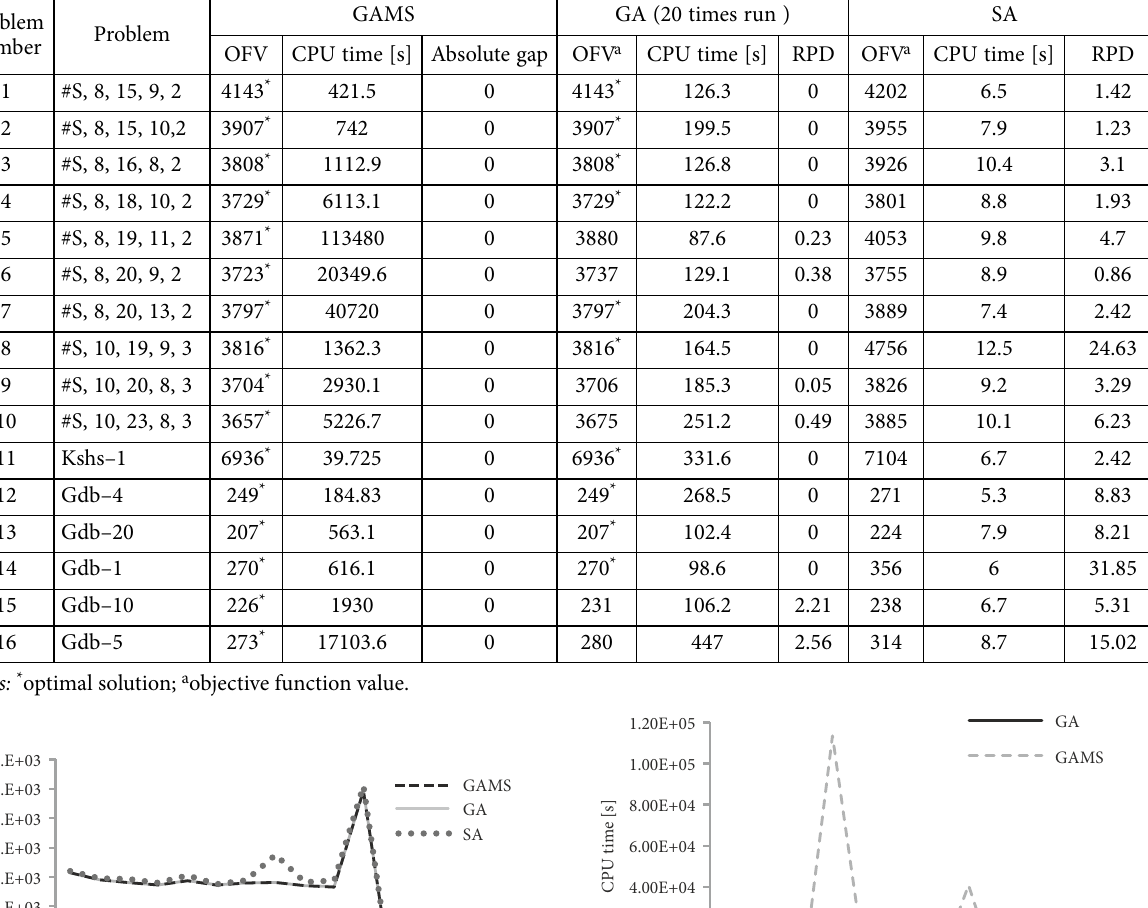
Table 8. Performance comparison of GA and SA algorithms with an exact solution in small-sized instances Problem number